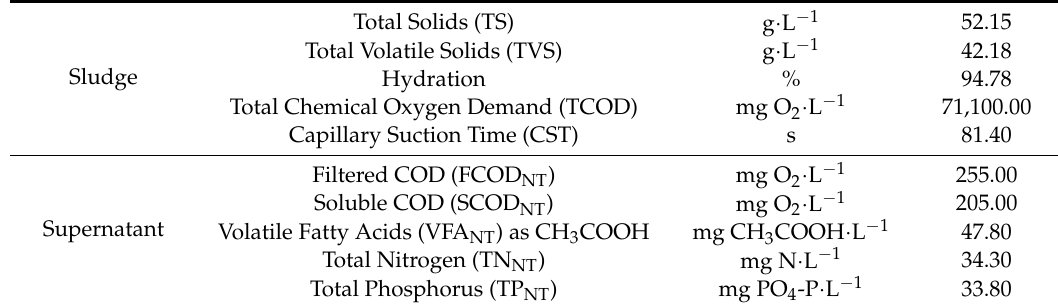
Table 1. Characteristics of excess sludge and its supernatant before